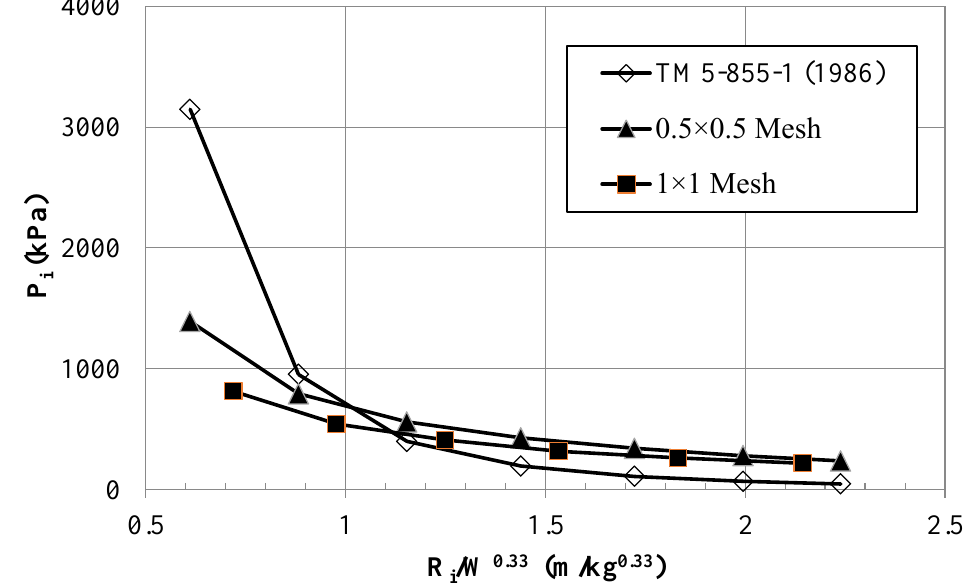
Fig. 4. Comparison of peak free-field pressure induced by blast loading from numerical method and that introduced by TM5-855-1 for two different grid